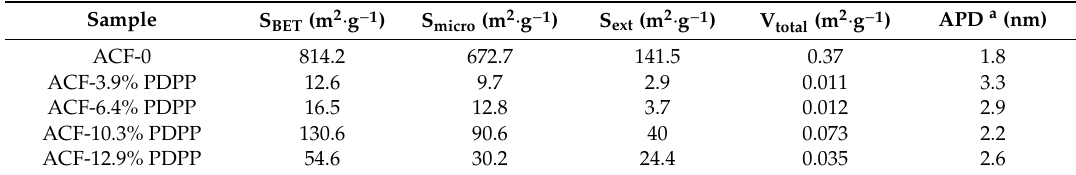
Table 5. Surface texture properties of ACFNs prepared from PAA / PDPP fibrous networks with di ff erent